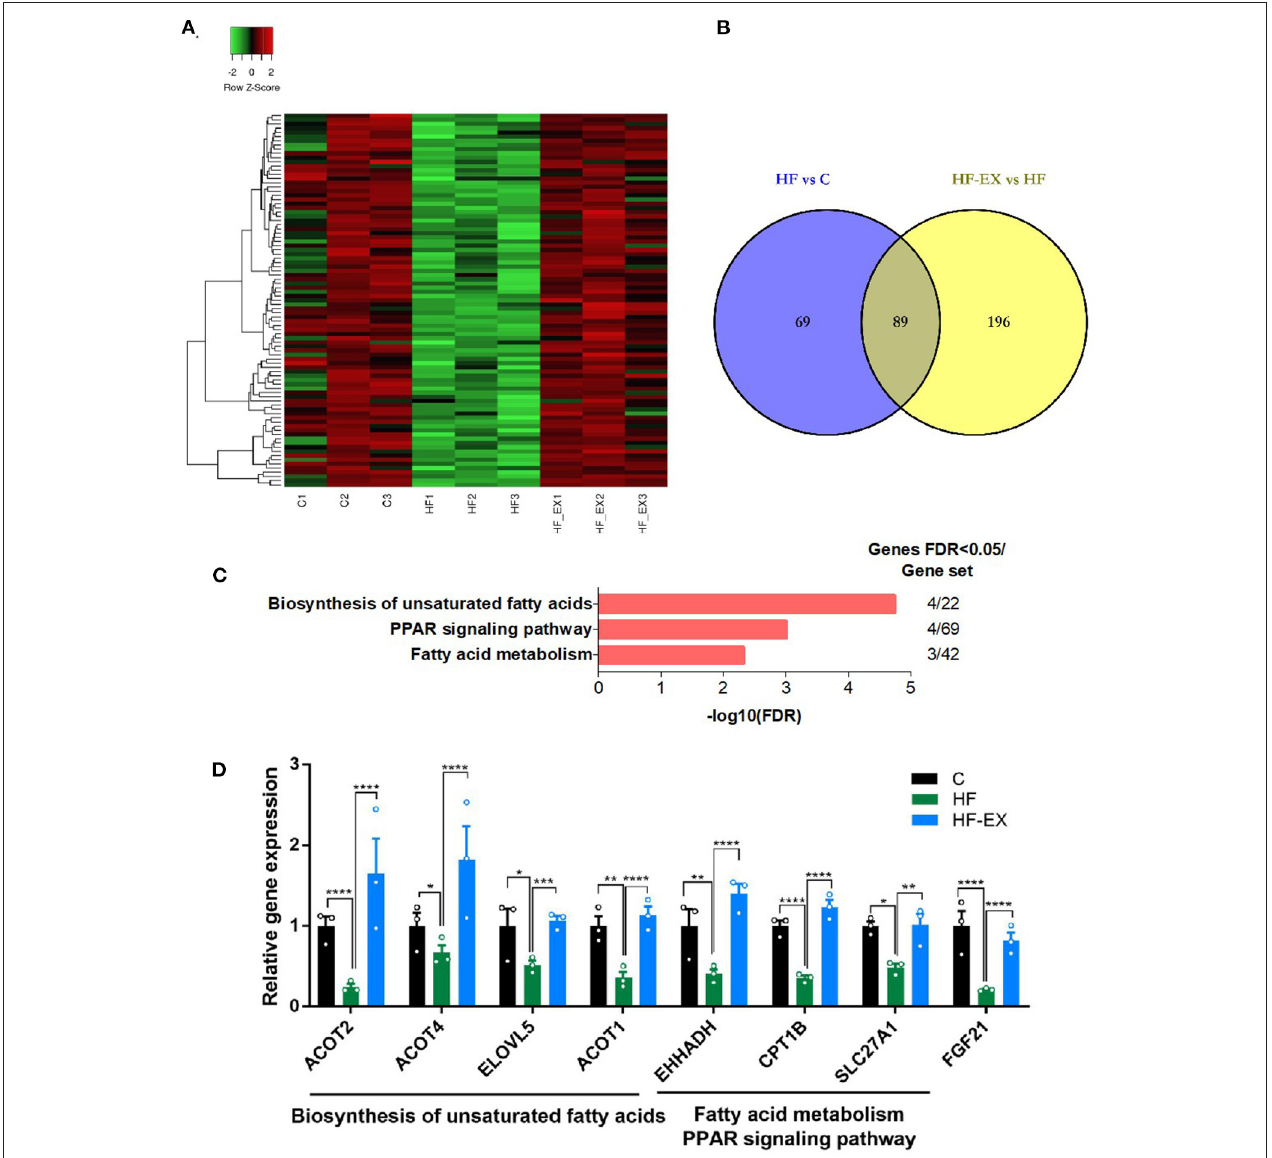
FIGURE 4 | Hepatic genes that were down-regulated by maternal HFD and up-regulated by maternal exercise and their functional analysis in adult offspring. (A) Heatmap of the differentially expressed genes; (B) Venn diagram of the differentially expressed genes; (C) KEGG pathway enrichment of the differentially expressed genes; (D) differentially expressed genes. C, offspring of dams fed the normal control diet; HF, offspring of dams fed the high-fat diet; HF-EX, offspring of dams intervened with a high-fat diet and exercise; HFD, high-fat diet. Data are expressed as means ± SD ( n = 3/group). Mean values were significantly different between the groups: * p < 0.05, ** p < 0.01, *** p < 0.001, **** p < 0.0001.